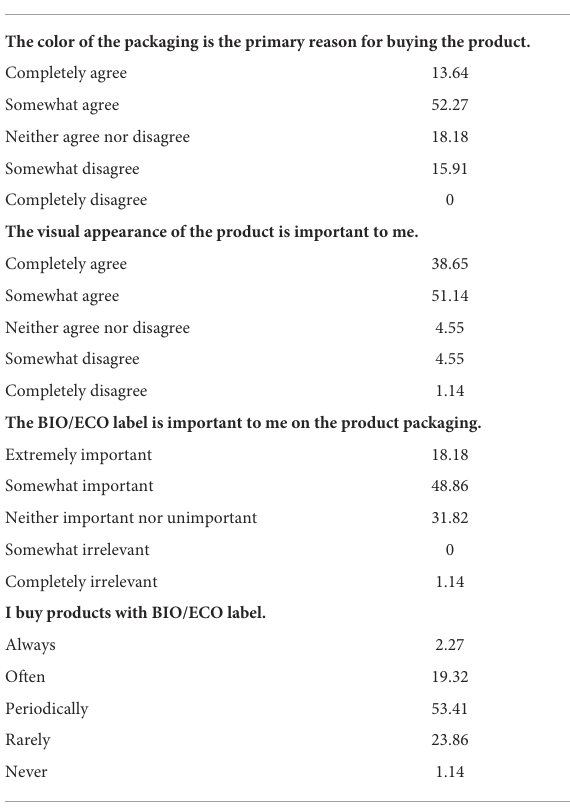
TABLE 3 Participants answers in percentage (%) to the question “What of the following applies to the product you just saw?”